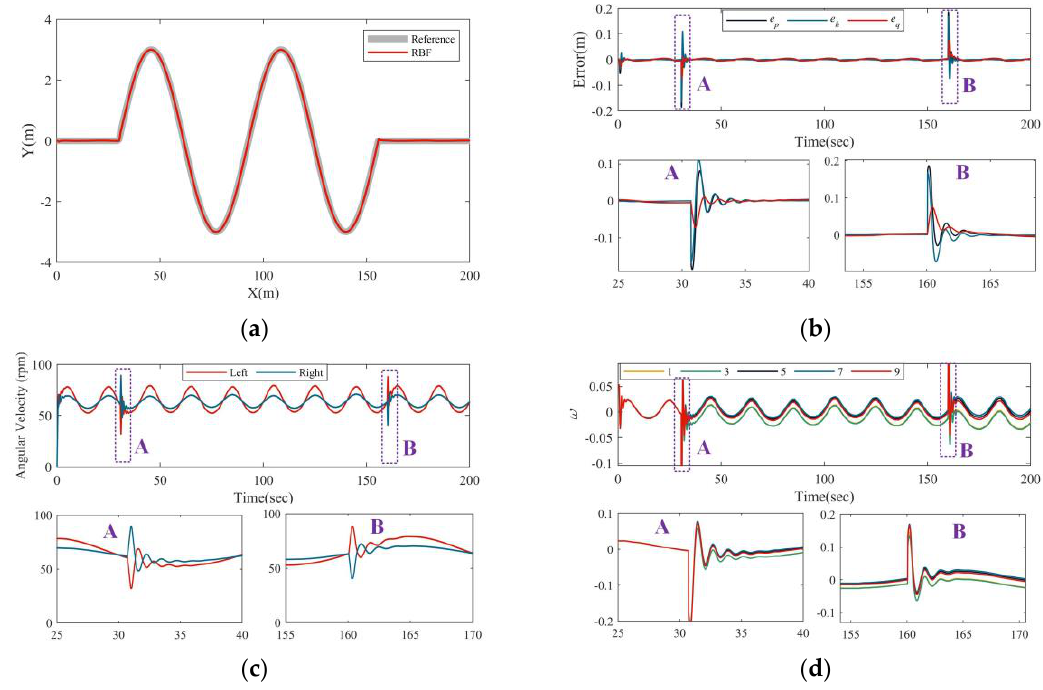
Figure 7. Tracking results of the proposed framework under a snaking path maneuver: ( a ) trajectory, ( b ) tracking errors, ( c ) angular velocity of the left and right driving wheels and ( d ) weights of the RBF network.